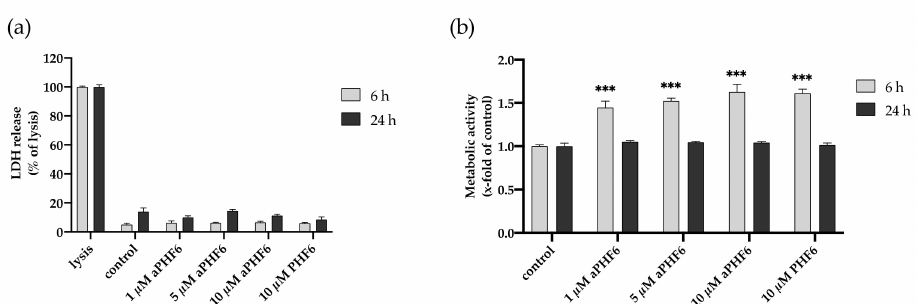
Figure A2. Effect of tau-PHF6 stimulation on HMC3 cell viability and metabolic activity at 6 and 24 h. ( a ) Cell viability assay: Treatment with 1–10 µ M aggregated PHF6 or 10 µ M unaggregated PHF6 did not significantly affect the LDH release at 6 or 24 h. ( b ) Metabolic activity assay: CTB assay revealed an increased metabolism with 1–10 µ M aggregated and unaggregated tau-PHF6 after 6 h, whereas no change in any treatment group was found after 24 h. Maximal lysed cells are treated as 100% or 1.0 positive control. *** p <